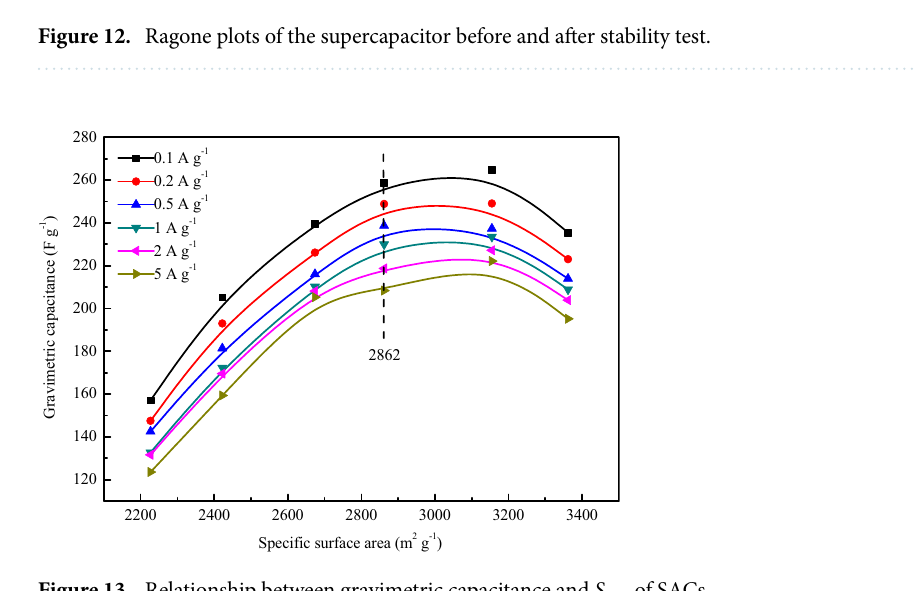
Figure 13. Relationship between gravimetric capacitance and S BET of